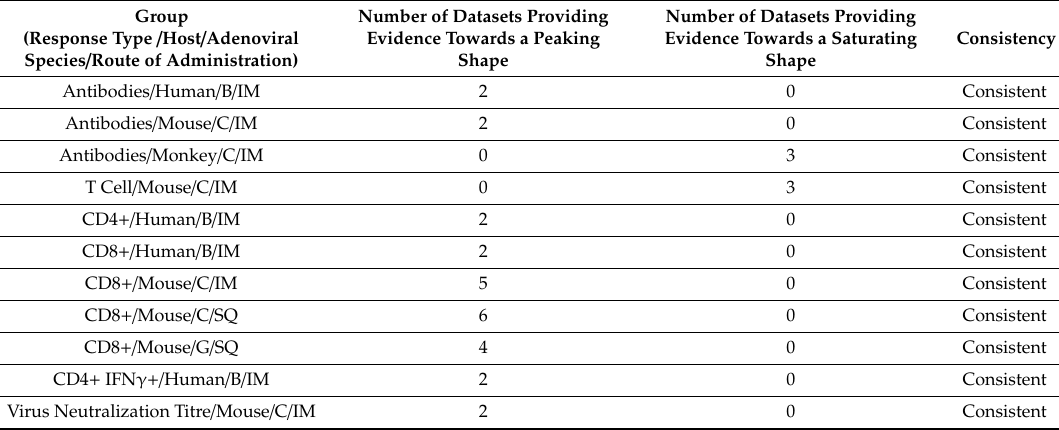
Table 3. Summary of consistency of curve shape within groups.